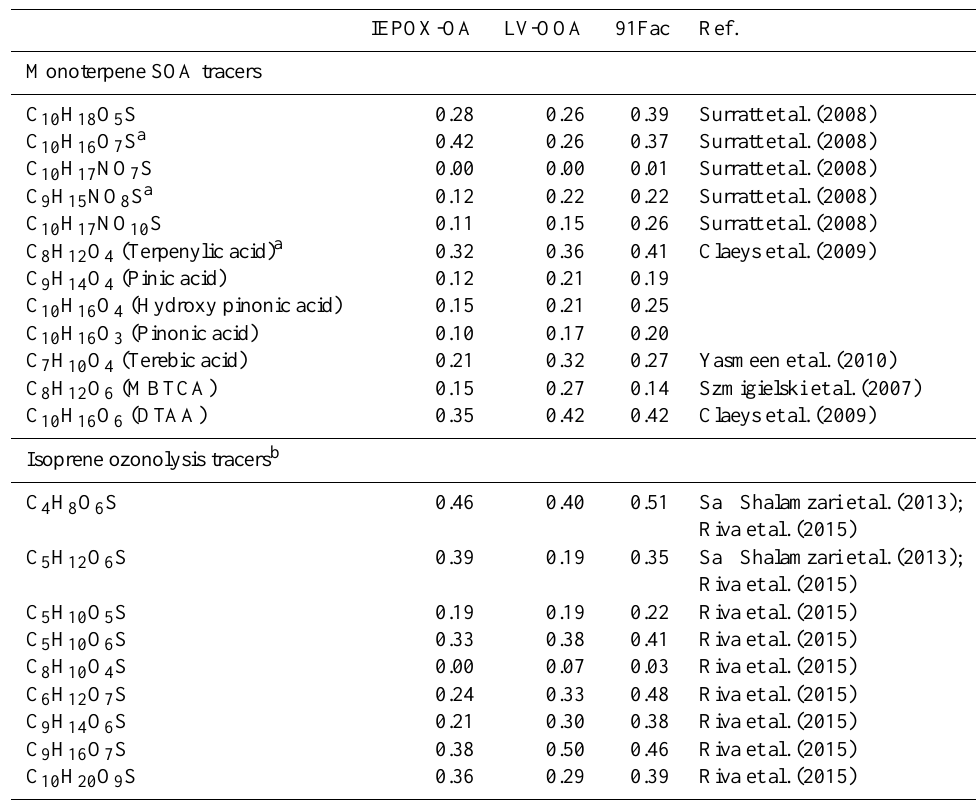
Table 3. Correlations of PMF factors resolved from OA measurements at LRK, TN, against SOA tracers from monoterpene chemistry and isoprene ozonolysis quantified during the 2013 SOAS. Some of the monoterpene SOA tracers have been published in Budisulistiorini et al.